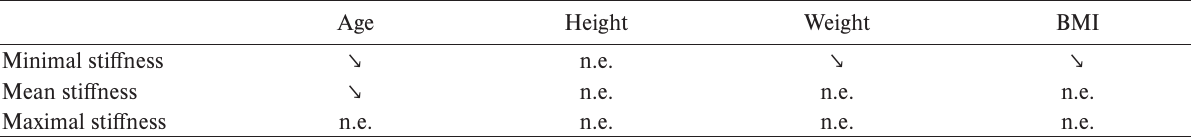
Table 3. Qualitative summary of the correlation of elastographic parameters with age, height, weight, and BMI. Age